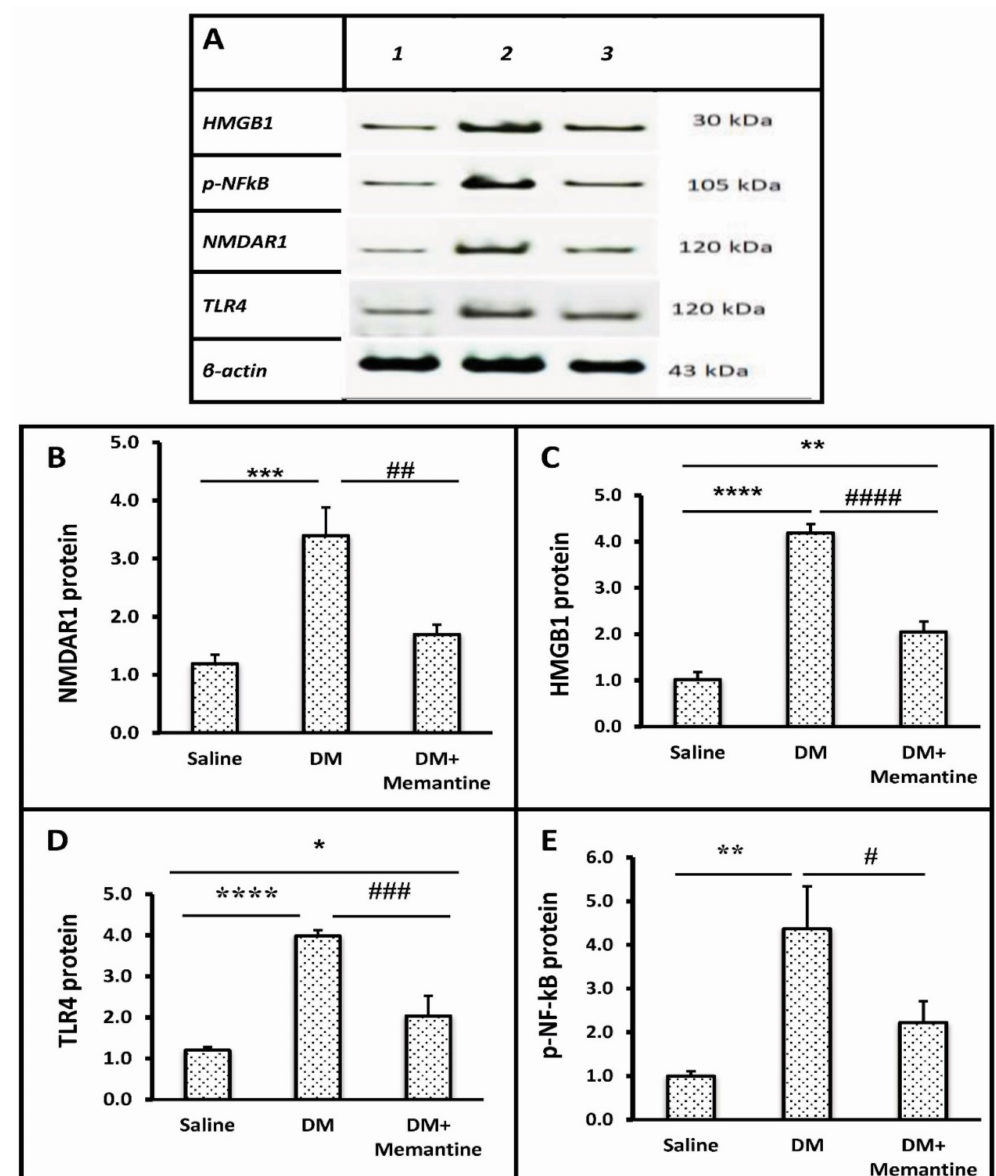
Figure 4. Effect of memantine on the spinal protein level of the inflammatory markers. ( A ) Spinal cord samples from saline (#1), diabetic (#2), and DM+memantine (10 mg/kg) groups (#3) were analyzed for ( B ) NMDAR1, ( C ) HMGB1, ( D ) TLR4 and ( E ) p-NF-kB. Data are mean ± SDM and analyzed by one-way ANOVA and Tukey’s tests. DM: diabetes mellitus mice, NMDAR1: n-methyl-D-aspartate receptors, HMGB1: high-mobility group protein 1, p-NF-kB: phosphorylated nuclear factor-kappa B, TLR4: Toll-like receptor 4, and SDM: standard deviation of the mean. * p < 0.05, ** p < 0.01, *** p < 0.001, and **** p < 0.0001 versus the saline group; # p < 0.05, ## p < 0.01, ### p < 0.001, and #### p < 0.0001 versus the DM